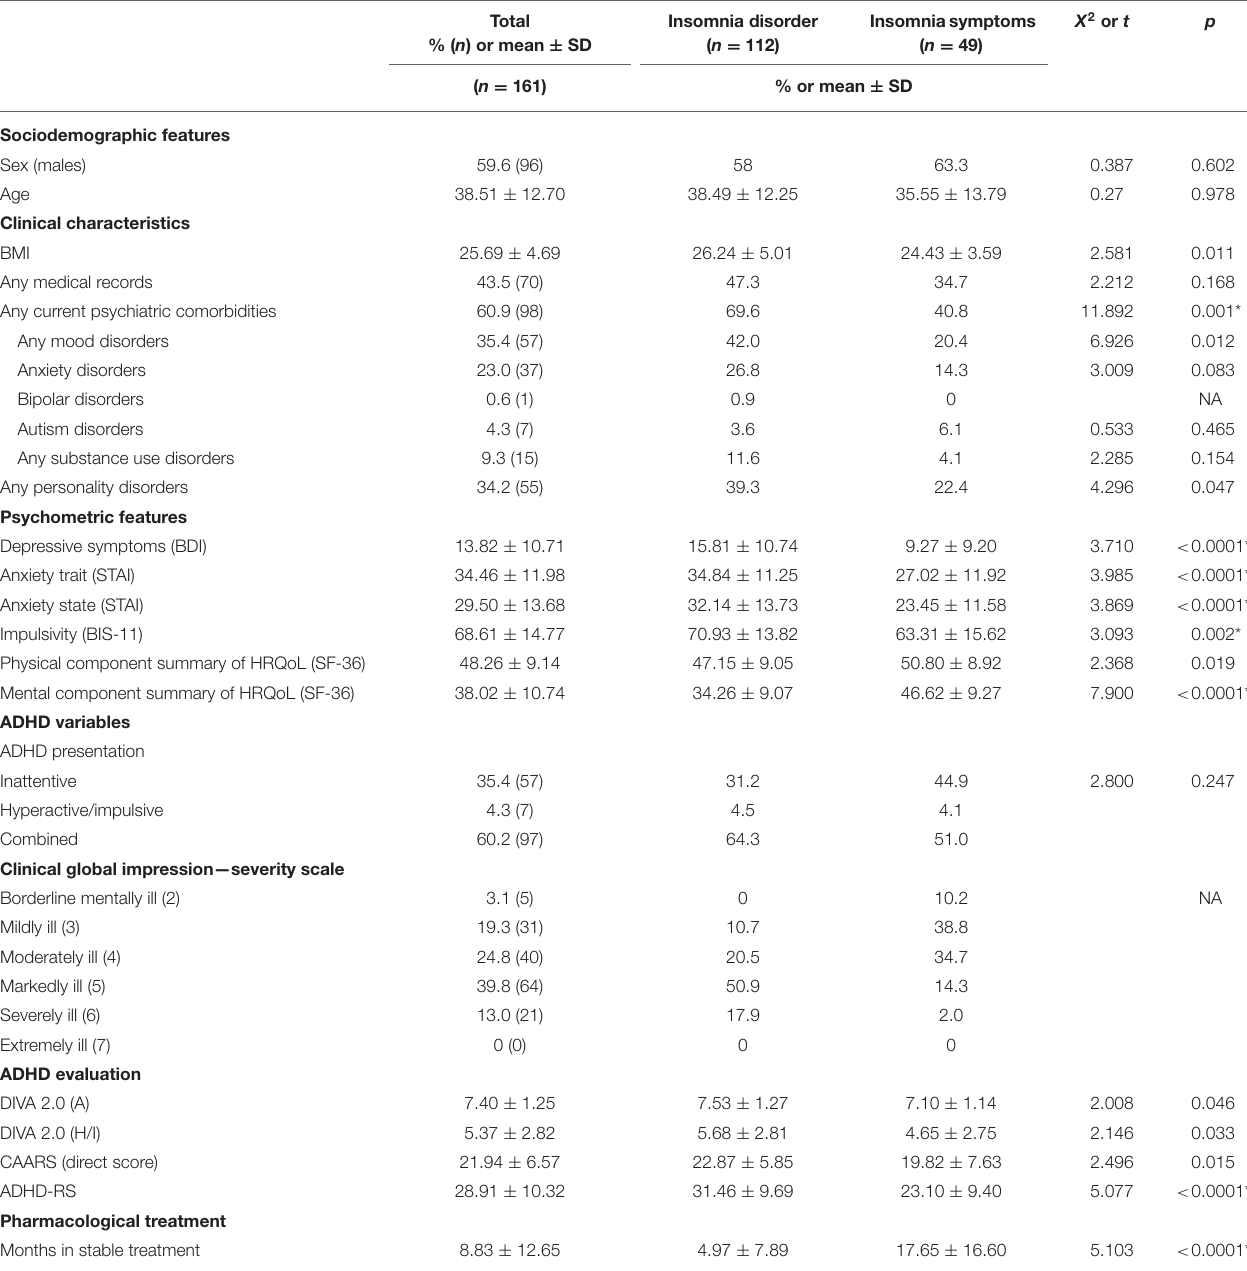
TABLE 4 | Sociodemographic and clinical features of ADHD patients according to insomnia disorder or insomnia